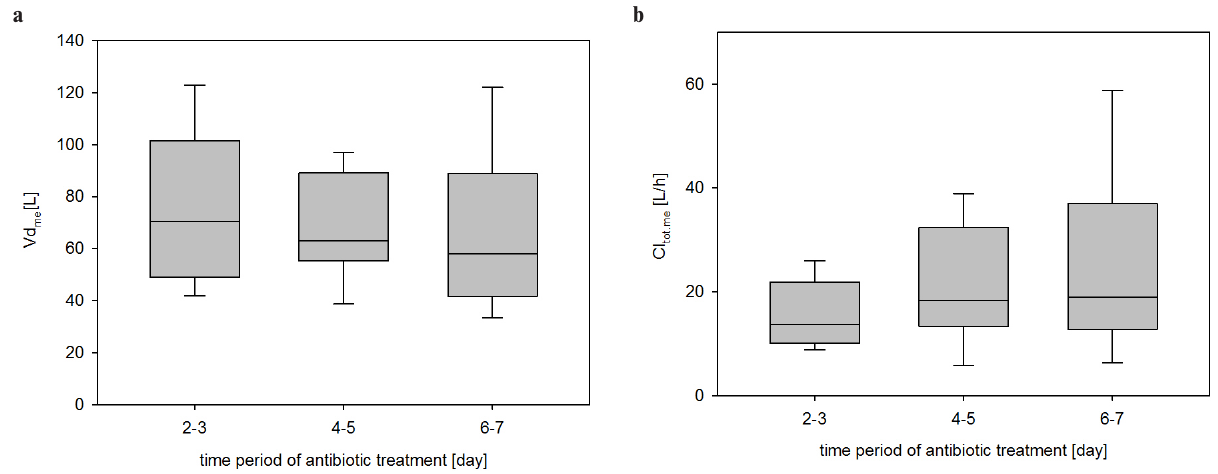
) and b/ total clearance (Cl ) estimated in septic patients treated with me tot.me